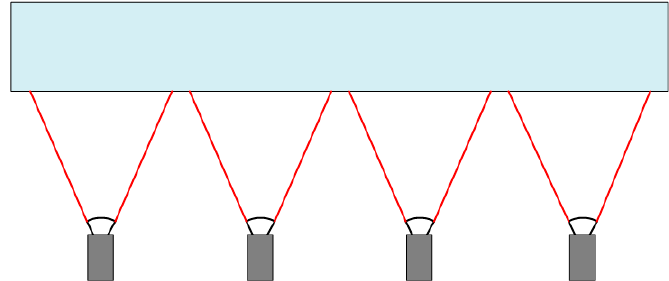
Figure 1. Multi-camera system without an overlapping field of view (FOV).